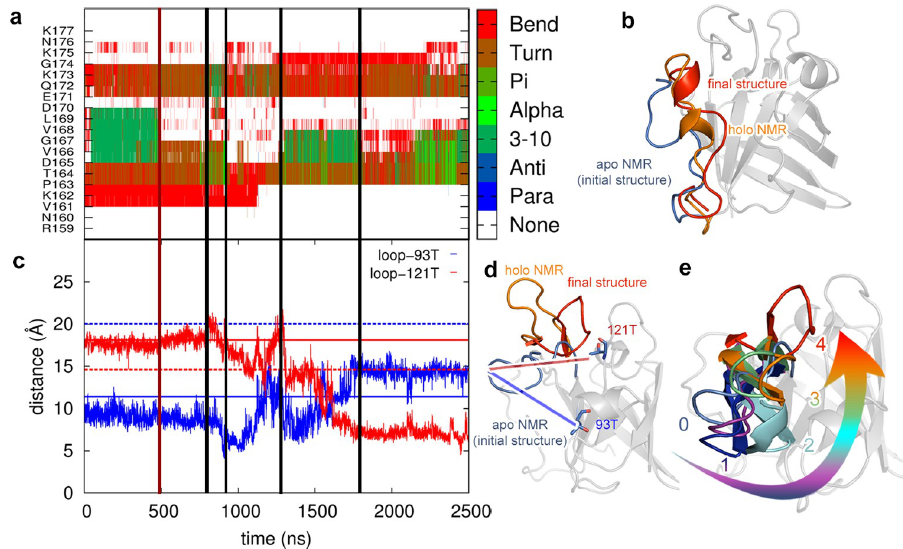
Fig 3. Structural changes in the disordered and the dynamic loops during the SrtA-Ca simulation. a) Changes in the secondary structure of the disordered loop. b) Representative structures of the disordered loop. c) Variations of the distances between the tip part of the loop (189E to 192G) and two reference amino acids 93T (blue lines) and 121T (red lines). Solid and dashed lines show the reference distances for the apo- and holo-NMR structures, respectively. d) Initial (blue), final (red), and holo NMR (orange) conformations of the dynamic loop. The residues used to follow loop motion are shown by stick representation (93T and 121T). e) Representative structures of the dynamic loop showing the direction of the